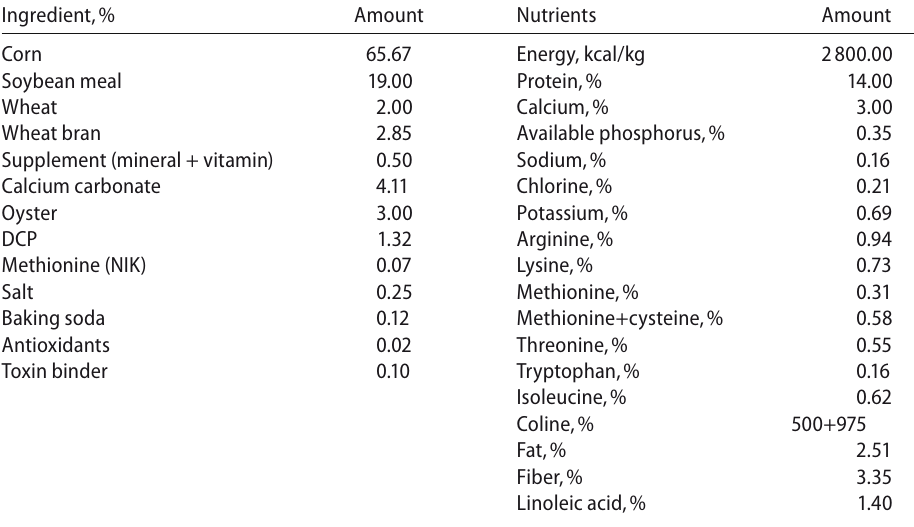
Composition of the diet used in all